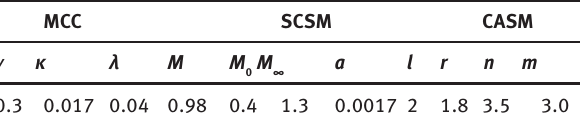
Table 5: MCC, SCSM and CASM parameters for the grey